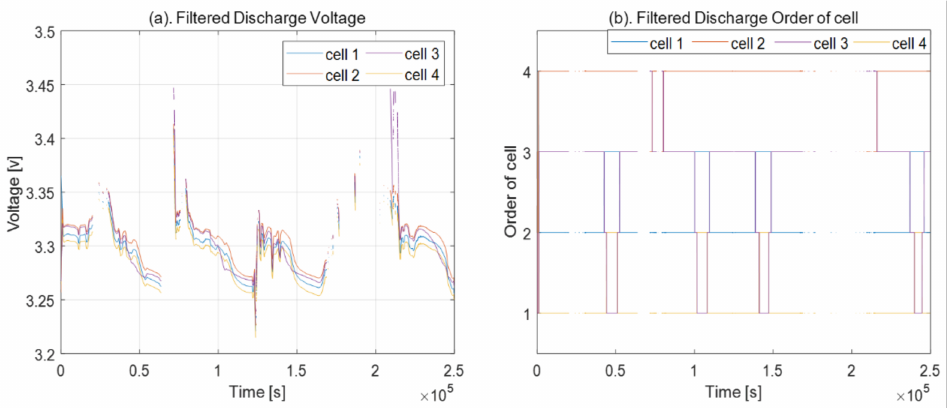
Figure 15. Capacity problem (( a ) filtering the discharge part in Figure 13 (left) and ( b ) order of cell